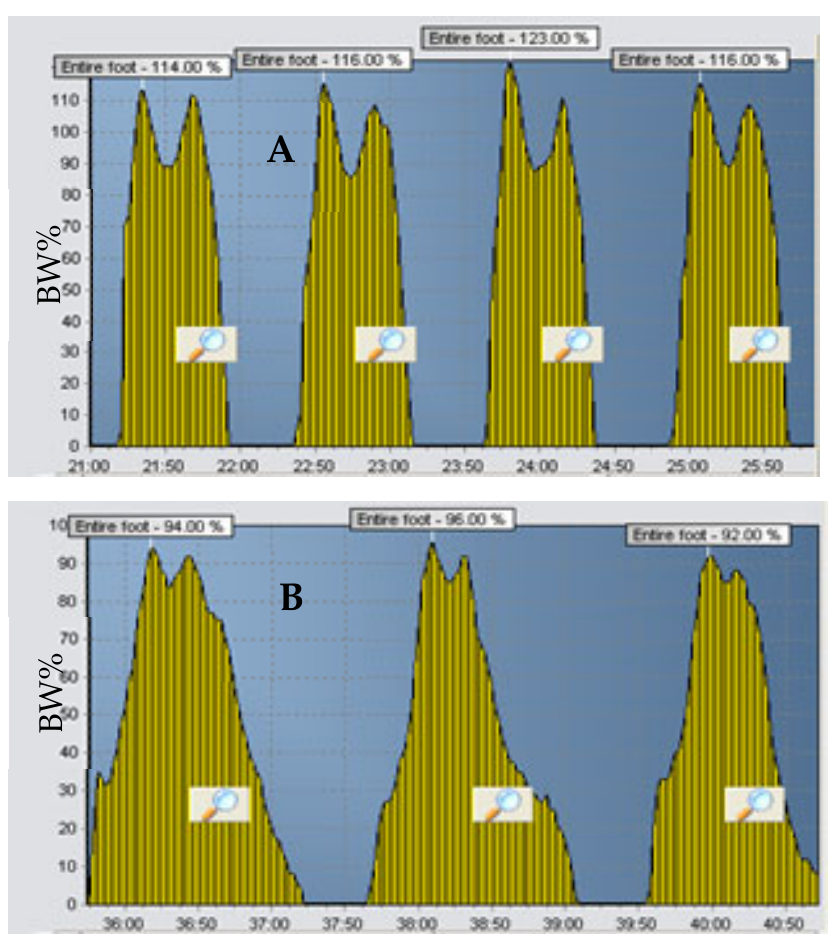
Figure 2. Unusual vertical GRF of two patients’ entire paretic gait cycle six months post-stroke ( A , B ). Vertical GRF is presented as a percentage of body weight (BW%).